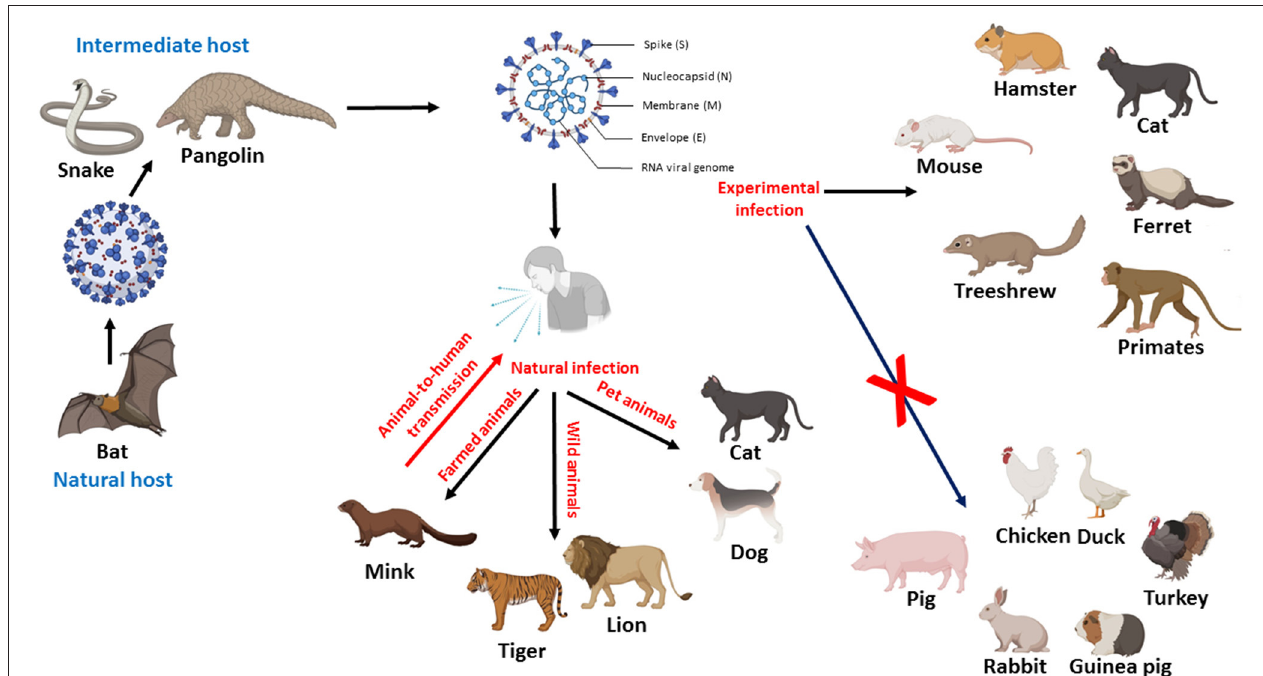
FIGURE 1 | Diagram showing the possible role of animals in the transmission of SARS-CoV-2, potential intermediate hosts, natural and experimental infection of animals. Figure was created with